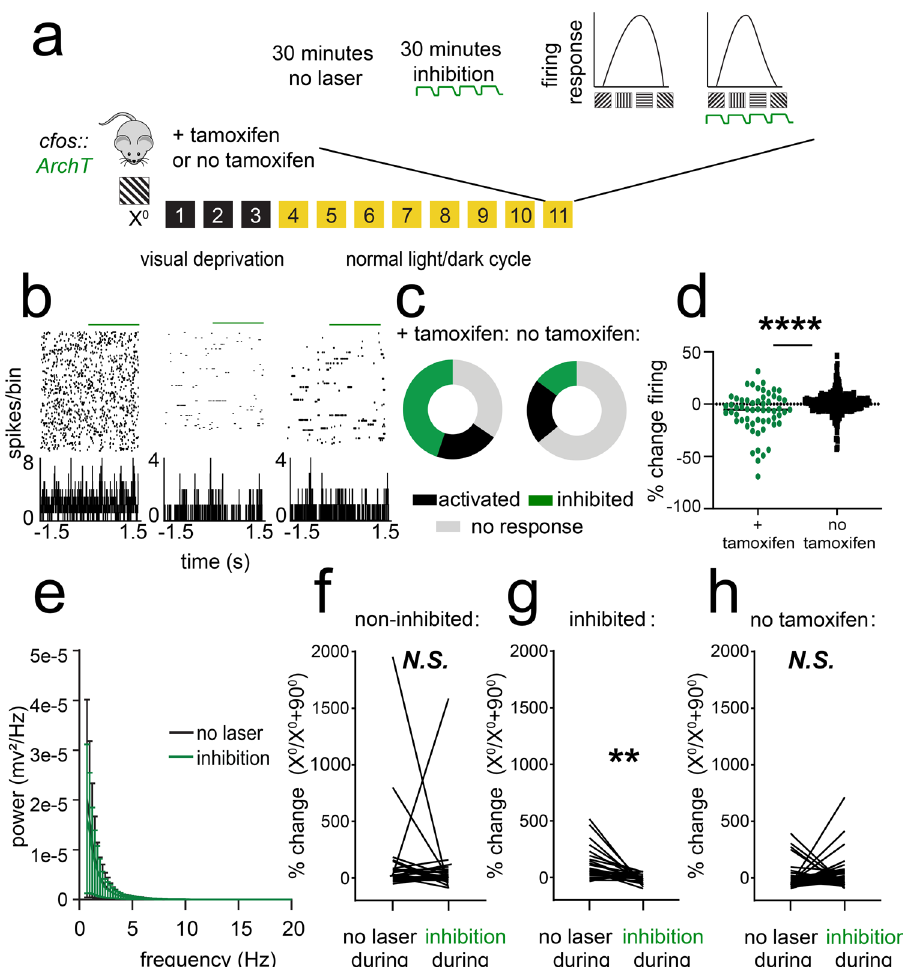
Fig. 6 Optogenetic inhibition of orientation-selective TRAPed V1 ensembles alters orientation preference in surrounding V1 neurons. a cfos::ArchT mice were presented with an oriented grating ( X °) for TRAP. Eleven days later, V1 neurons were recorded from anesthetized mice across 30 min of